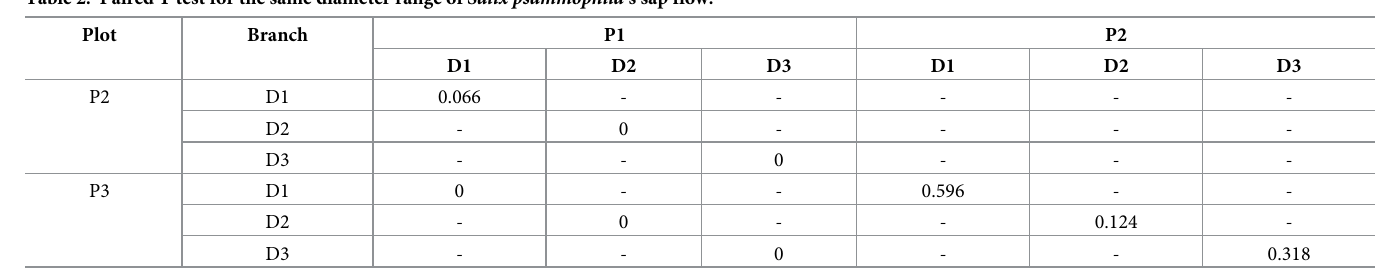
Table 2. Paired T test for the same diameter range of Salix psammophila ’s sap flow. Plot